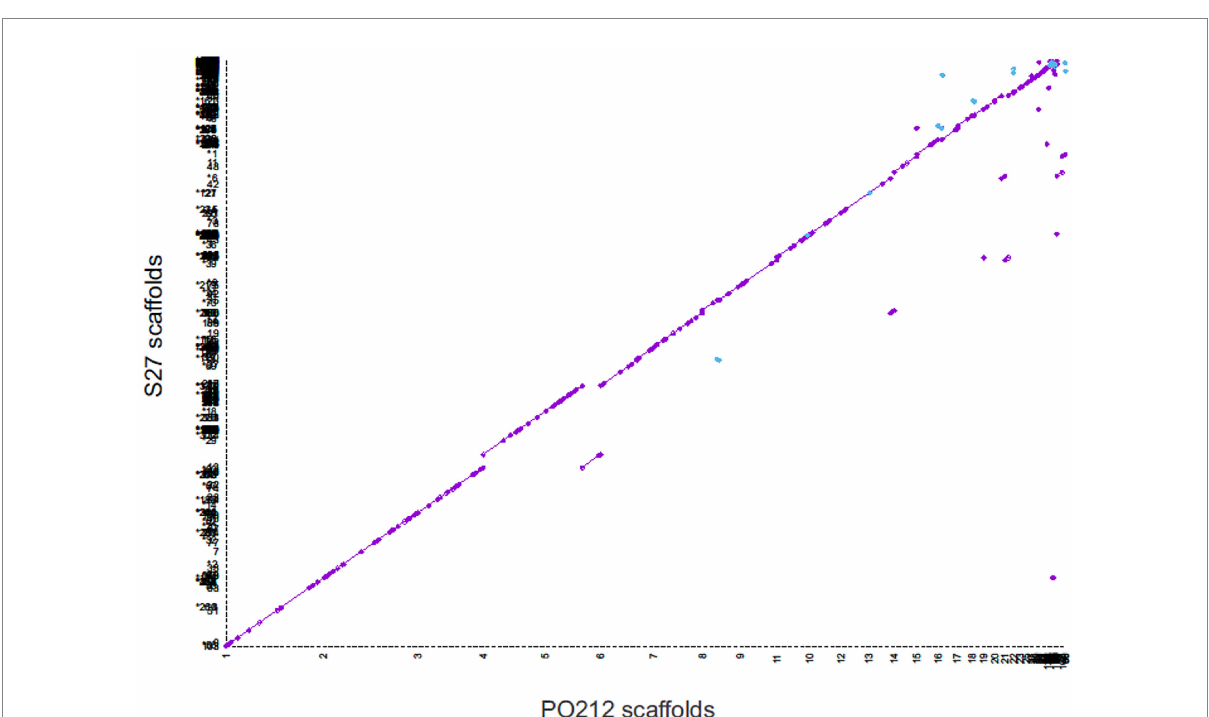
FIGURE 4 Whole-genome dot-plot showing regions of forward alignment (in purple), translocations (displacements from the diagonal), inversions (in blue), and duplications (parallel diagonal lines) between Penicillium rubens strains 212 (PO212) and S27. The PO212 assembly ( X axis) was used as a reference.